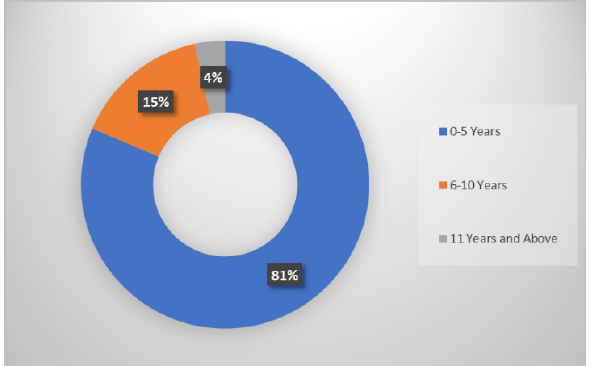
Figure 12: Experience of Volunteer Mappers by Years